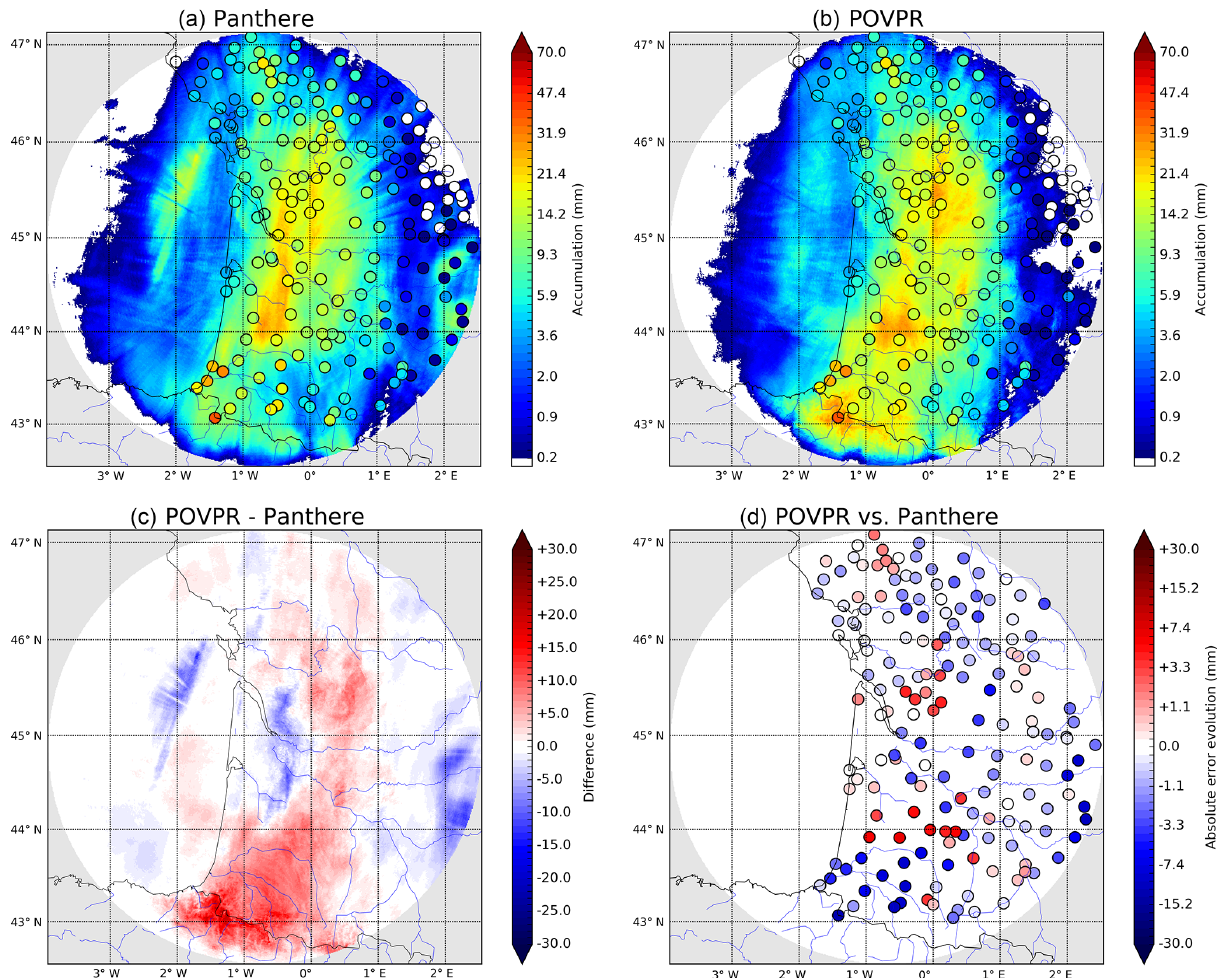
Figure 11. Same as Fig. 6 for the 3 March 2017 event between 18:00 and 00:00UTC on the Bordeaux radar